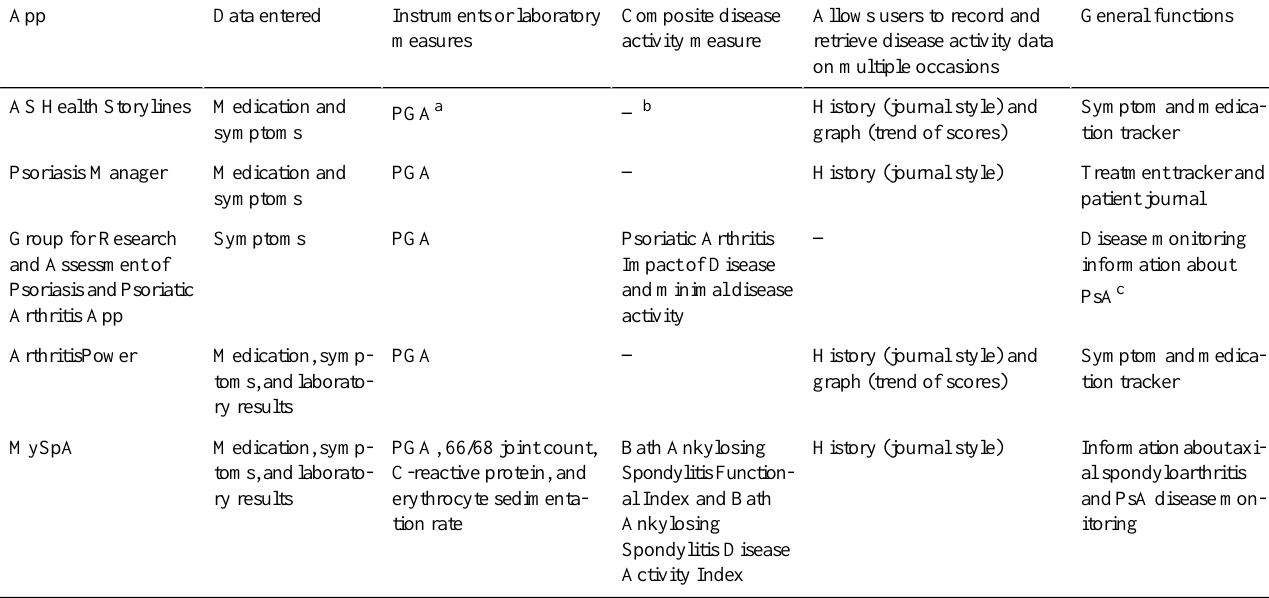
Table 4. App inclusion of the various spondyloarthritis activity measure and component measurement instruments and other functionality of included apps.